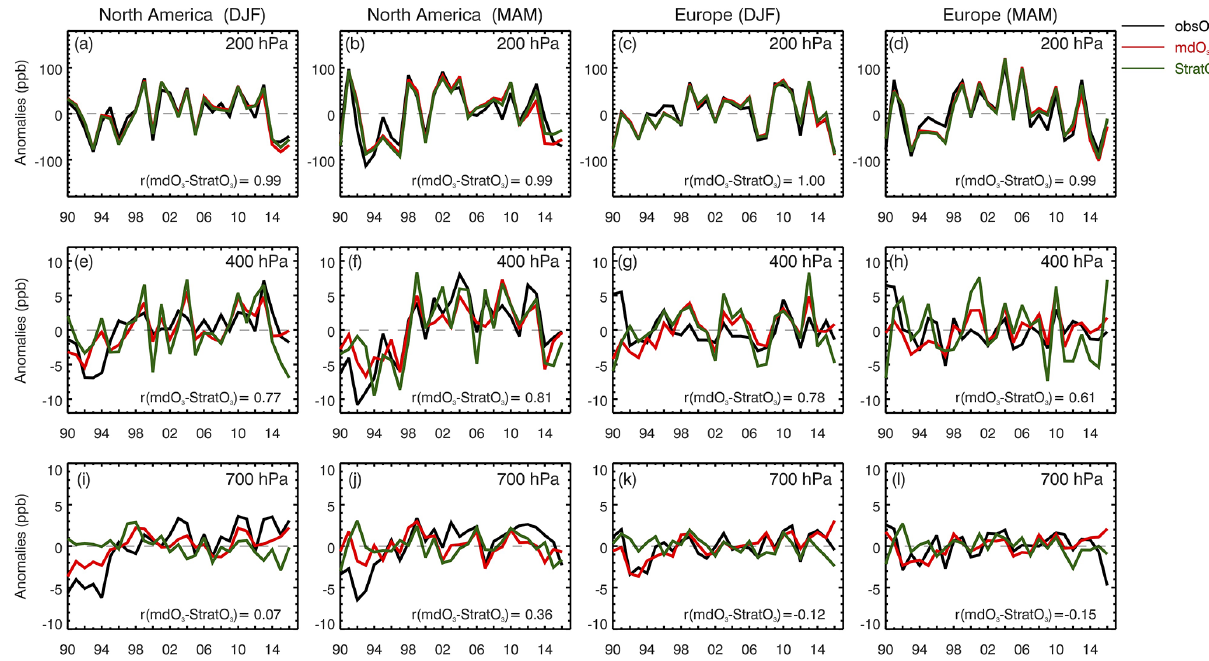
Figure 3. Similar to Fig. 2 but adding the simulated StratO 3 anomalies (green). The correlation coefficients between simulated ozone and StratO 3 are shown in